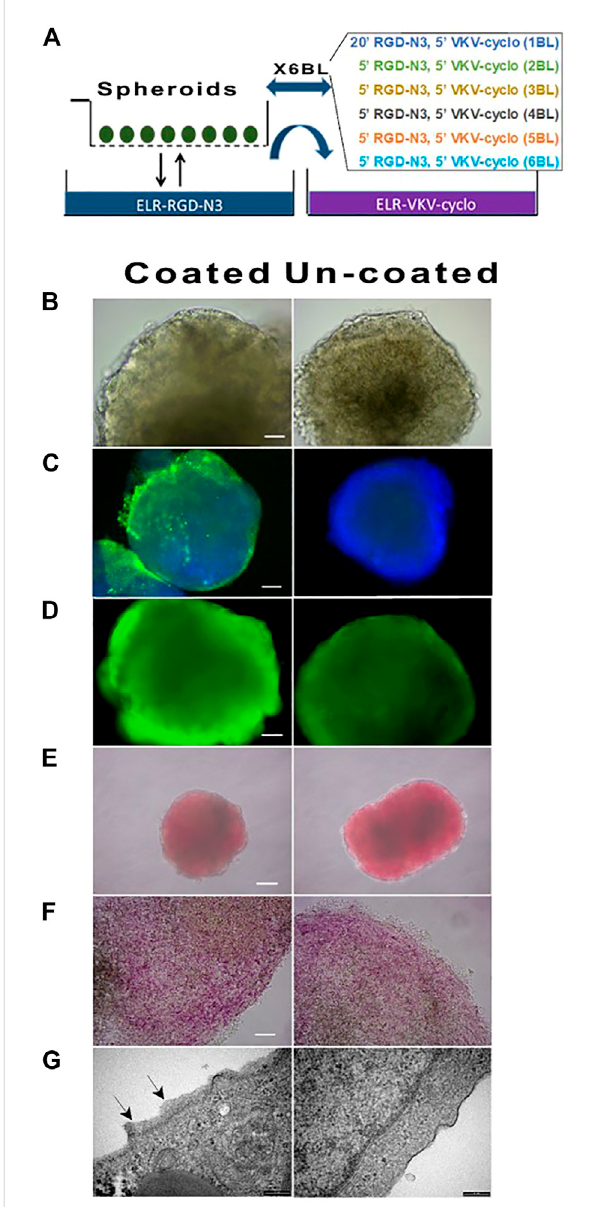
Morphology, viability, and DTZ assay of coated and un-coated hiPSC at DIV27. (A) Schematic representation of spheroids coating procedures. (B) Morphology (40X); (C) Immuno fl uorescence performed with anti-elastin antibody: the thin layer of ELRs on coated unlike uncoated cell spheroids was evident (20X); (D) Viability (40X) and (E) DTZ staining of coated vs un-coated spheroids did not show differences (4X); (F) Details of spheroids DTZ-stained upon squeezing by coverslip: individual areas within the cell spheroids intensely stained in red were visible (40X); (G) TEM micrograph showed coating of ELRs (black arrows) ascomparedto untreated cells